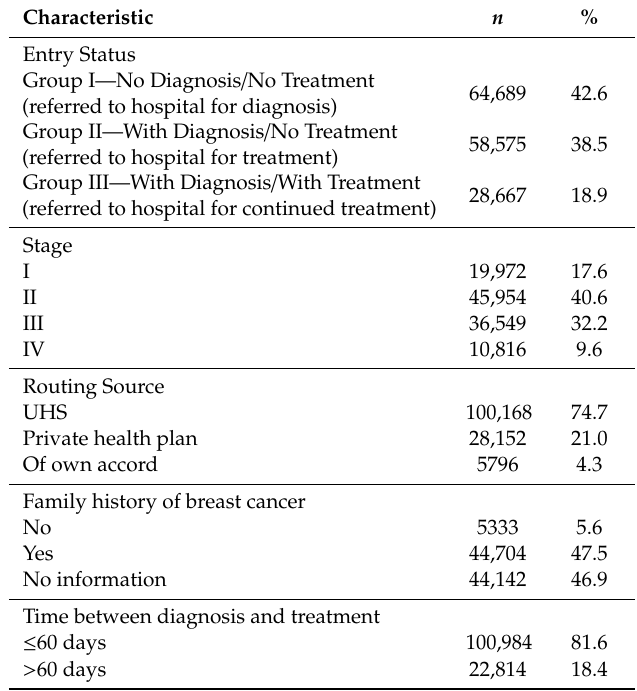
Table 1. Clinical characteristics of women diagnosed with breast cancer in Brazil between 1998 and 2012.